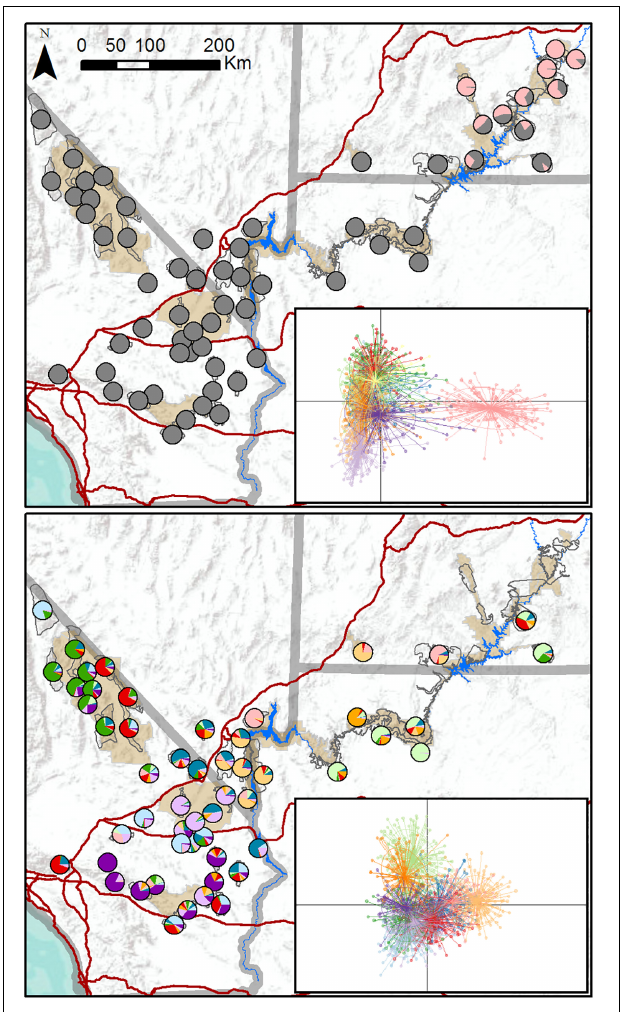
FIGURE 2 | Maps of population assignments to genetic clusters from initial DAPC analysis of all 62 desert bighorn sheep populations in study area (upper panel), and from secondary DAPC analysis of further hierarchical structure after removing populations in southeastern Utah assigned to distinct cluster in initial analysis (lower panel). In pie charts in upper panel map, all clusters other than distinct southeastern Utah cluster are shown in gray to highlight key genetic division. Inset figures in each panel are scatterplots of first two principal component axes from DAPC analyses, with dots representing individuals, colors representing inferred clusters, and ellipses represent 67 percent confidence regions for clusters. Clusters with less overlap in scatterplot are more genetically distinct. Major water barriers and interstate highways are shown in dark blue and red, respectively, tan shaded areas show National Park Service units; and hollow gray polygons show habitat polygons associated with